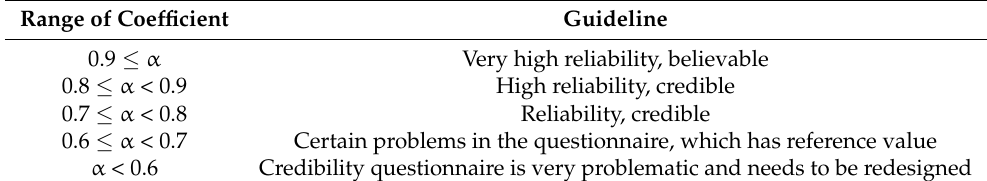
Table 2. Value range of Cronbach’s α coefficient. Range of